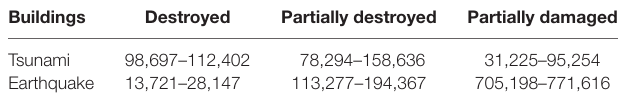
Table 8 | building damage statistics for the 2011 Tohoku eQ disaggregated for tsunami and earthquake. buildings Destroyed Partially